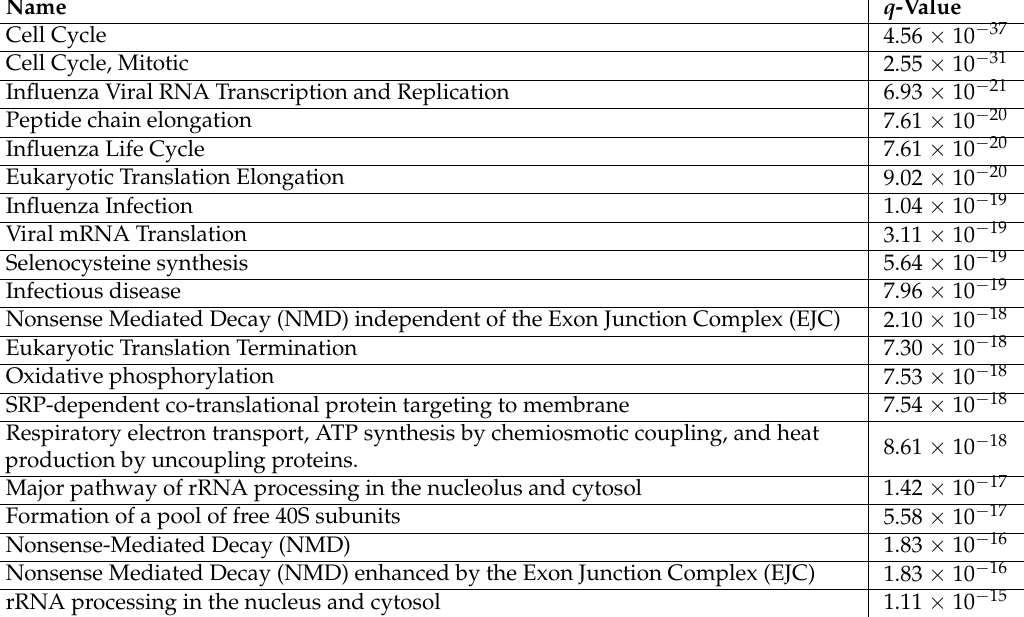
Table 2. ToppFun functional enrichment analysis—Biological Pathways. The top 20 significant pathways are shown below. ToppFun analysis revealed several pathways that were significantly deregulated related to cell cycle, transcription-translation-elongation, viral infection, mitochondrial energy production and oxidative